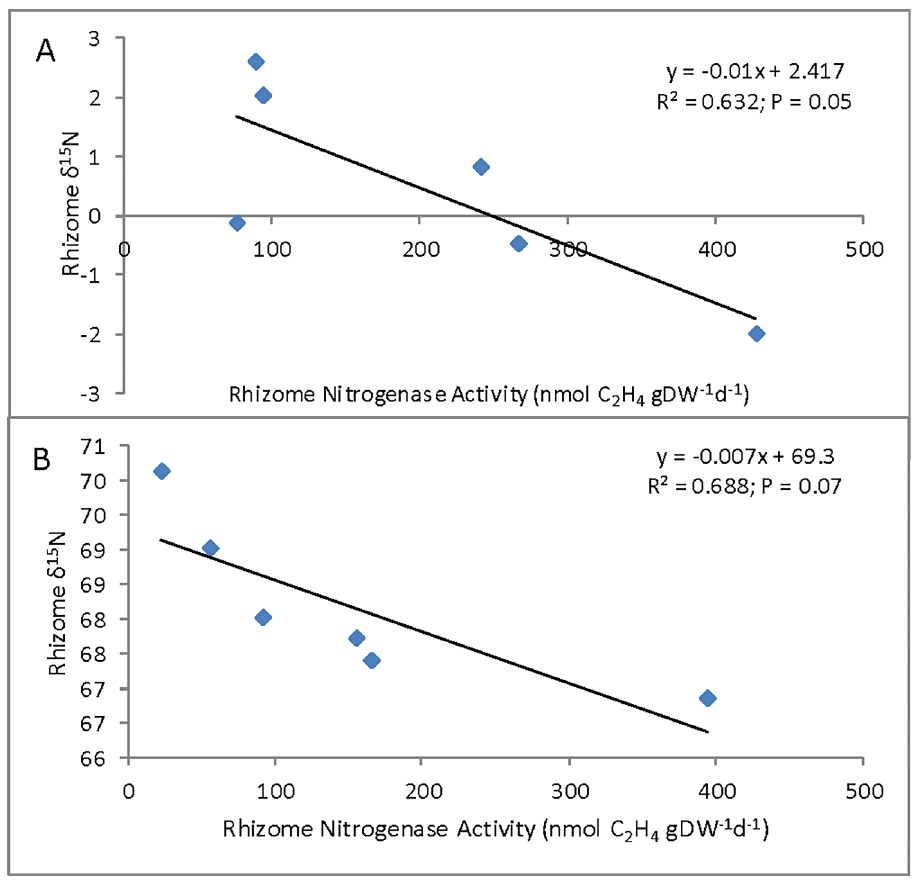
Fig 5. Relationship between rhizome nitrogenase activity expressed as ethylene production (nmol C 2 H 4 gDW -1 d -1 ). and rhizome δ 15 N in Schoenoplectus californicus from the cultivation experiment zero N treatment (A) and high treatment (B). Each nitrogenase activity value is a mean of 3 replicates, isotope data are measured on pooled